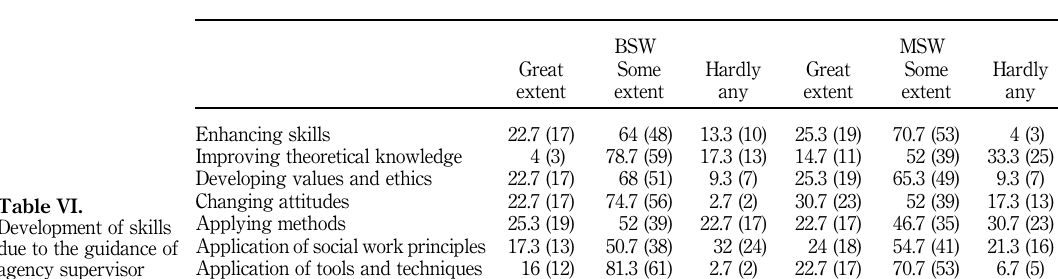
Figure 16. Plagiarism in field work reports/ assignments